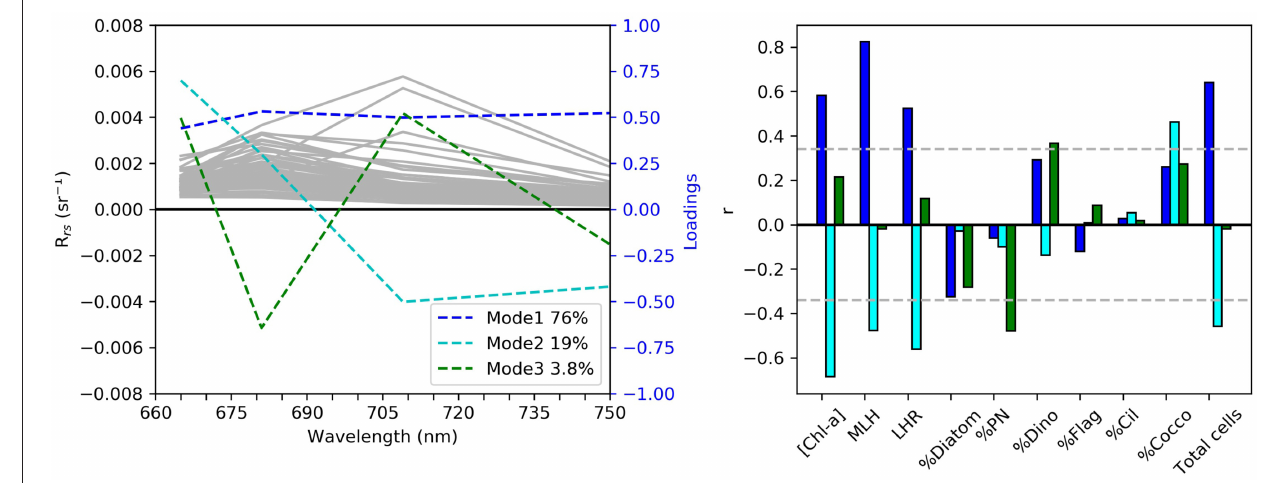
FIGURE 2 | Results from the principal component analysis of the in situ reflectance between 665 and 754 nm ( N = 68). In the left panel the gray lines indicate individual R rs samples, while the colored lines show the loadings of the top three modes of variability in the R rs dataset. In the right panel the bars are color-coded according to the corresponding modes of variance to show the correlation with [Chl-a], maximum line height, line height ratio, percentage composition of diatoms, Pseudo-nitzschia , dinoflagellates, flagellates, cilliates, and coccolithophores, as well as the total cell counts per sample. The gray horizontal lines indicate the 95 % significance level.